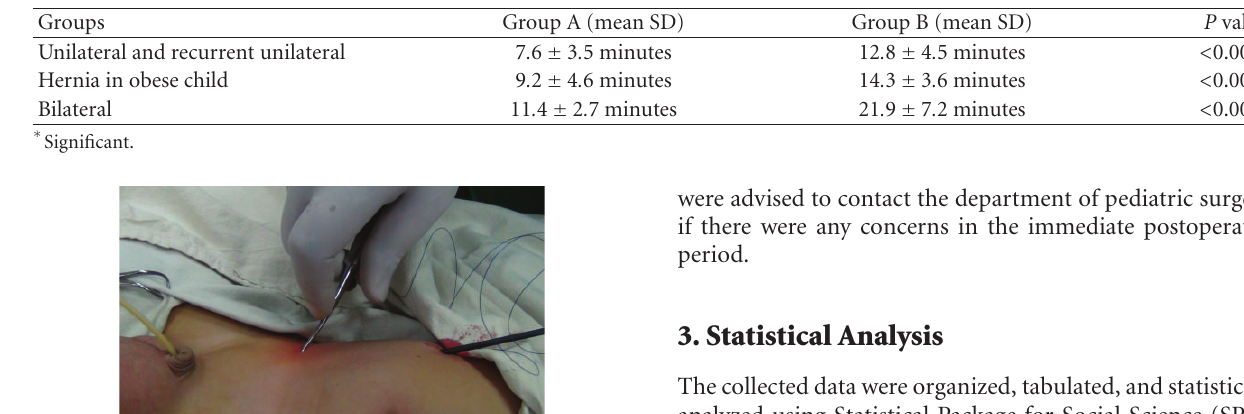
Table 2: Distribution of the studied groups according to operative time.